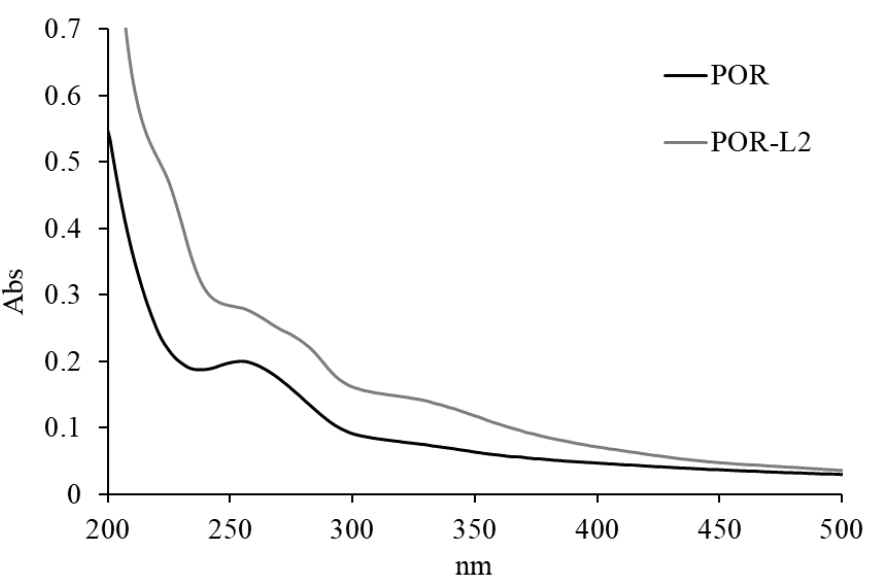
Figure 4. UV – vis absorption spectra of POR and POR-L2 in water, at a concentration of 0.2 Figure 4. UV–vis absorption spectra of POR and POR-L2 in water, at a concentration of 0.2 mg/mL. mg/mL. The spectra were measured with a 1 cm optical path quartz cell. The spectra were measured with a 1 cm optical path quartz